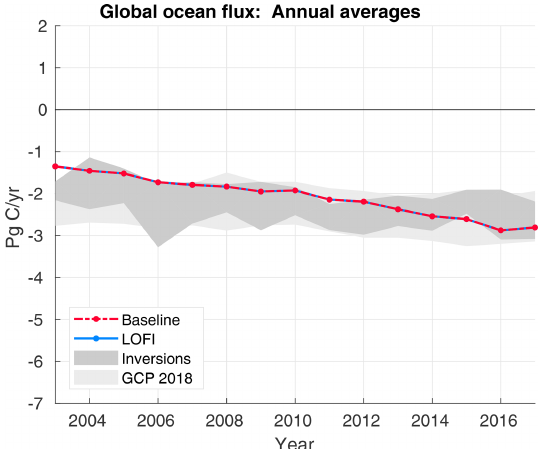
Figure 1. Global annual totals of LoFI ocean exchange fluxes (solid blue; identical to baseline) for 2003–2017. Minimum-to-maximum ranges of the inversion ensemble (dark grey) and GCP 2018 ocean biogeochemical model ensemble (light grey) are provided for com-